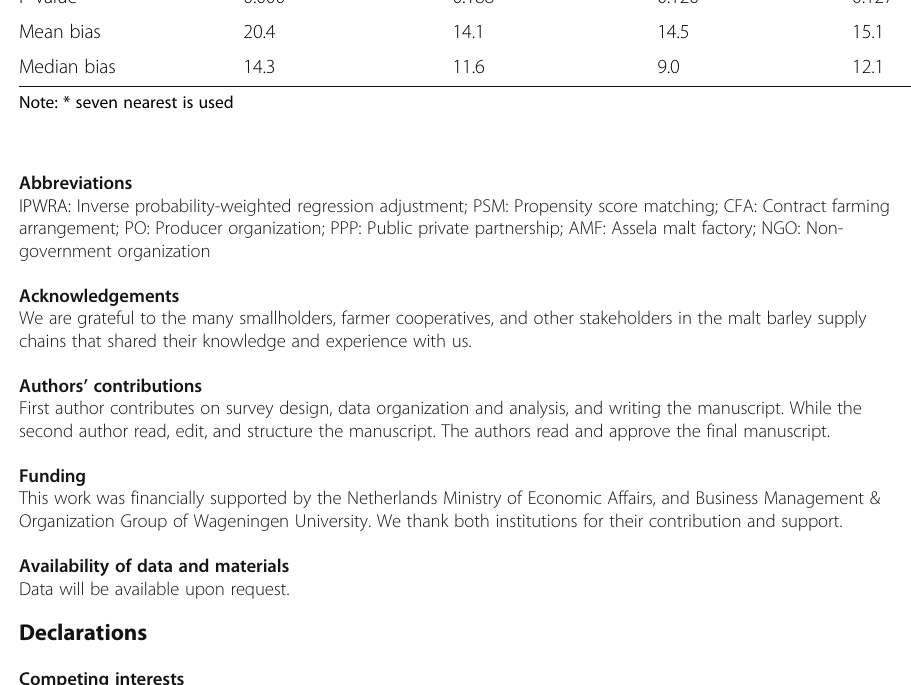
Before matching